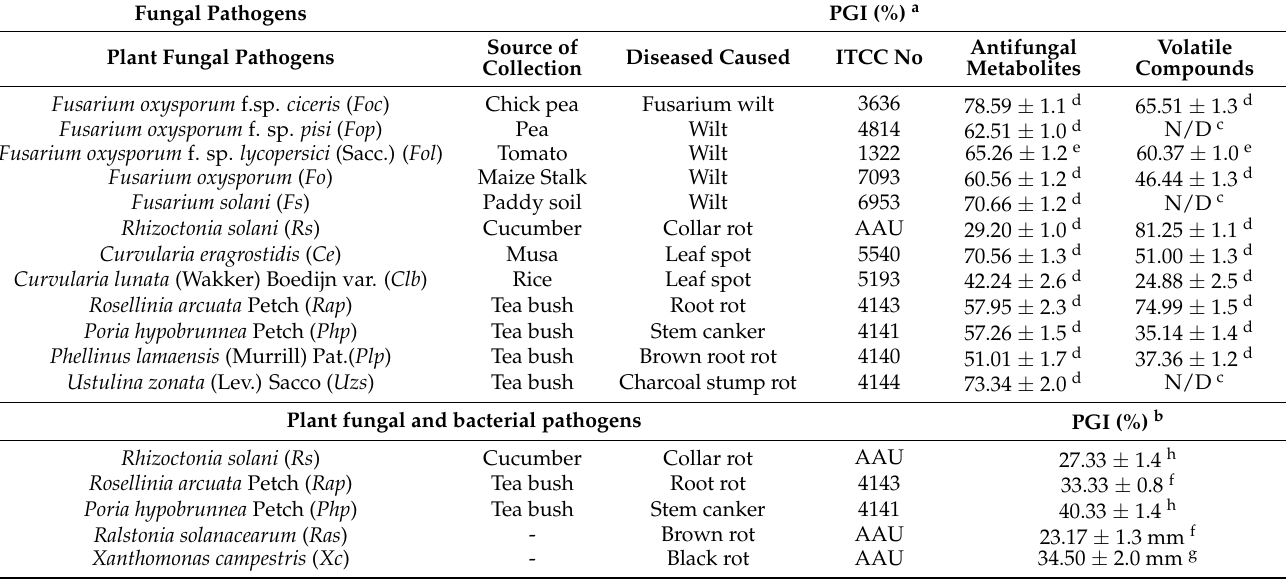
Table 3. Effect of the bacterial strain A7 on fungal and bacterial plant pathogen growth